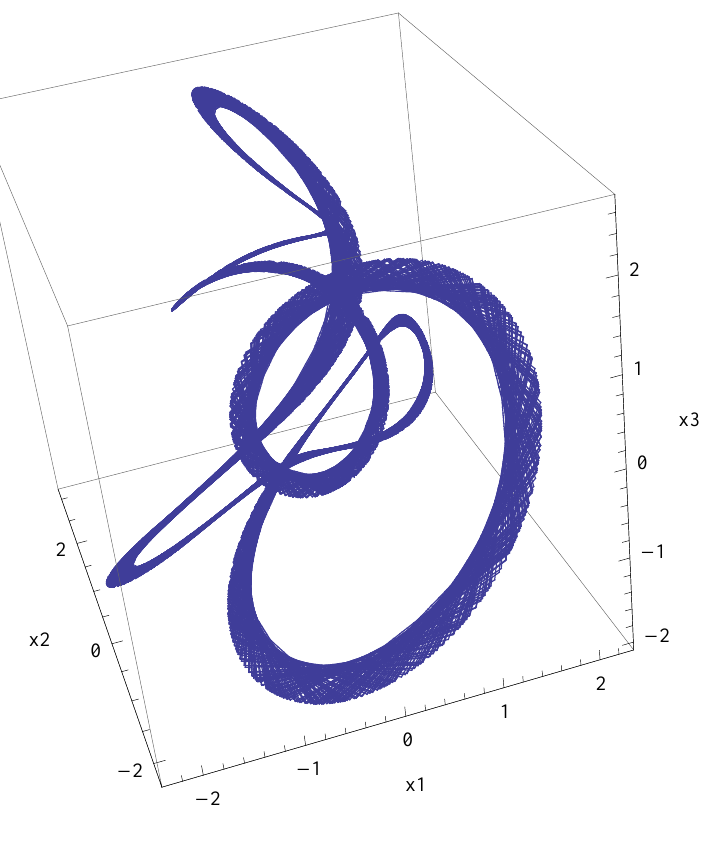
Figure 1: The Lie-Trotter integrator of the system (3), projection on ( Ox 1 x 2 x 3 ) plane ( a 1 = 10, a 2 = 2, a 3 = 3, x 1 (0) = x 2 (0) = x 3 (0) = p 1 (0) = p 2 (0) = p 3 (0) = 1